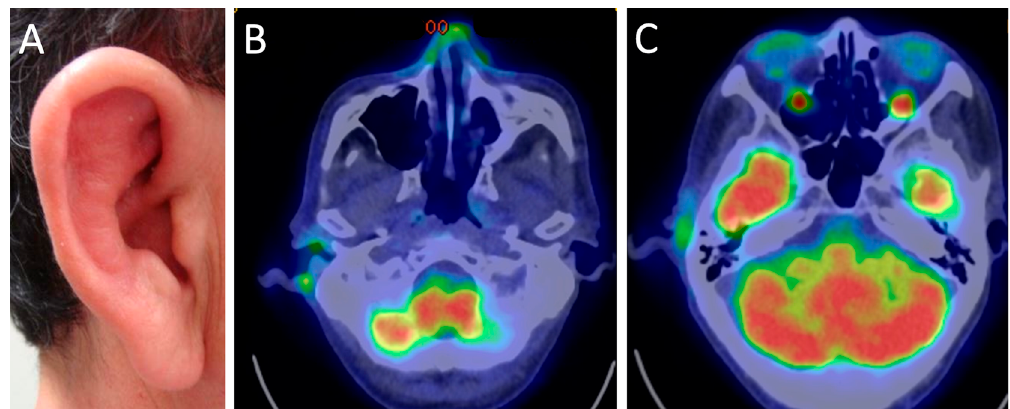
Figure 6. PET/CT images of a patient with right auricular chondritis, nasal chondritis, and bilateral scleritis due to RPC. The right pinna is red and swollen ( A ), and FDG-PET/CT shows high signal intensities (green) in the right auricle, nasal cartilage ( B ), and bilateral sclera ( C ).